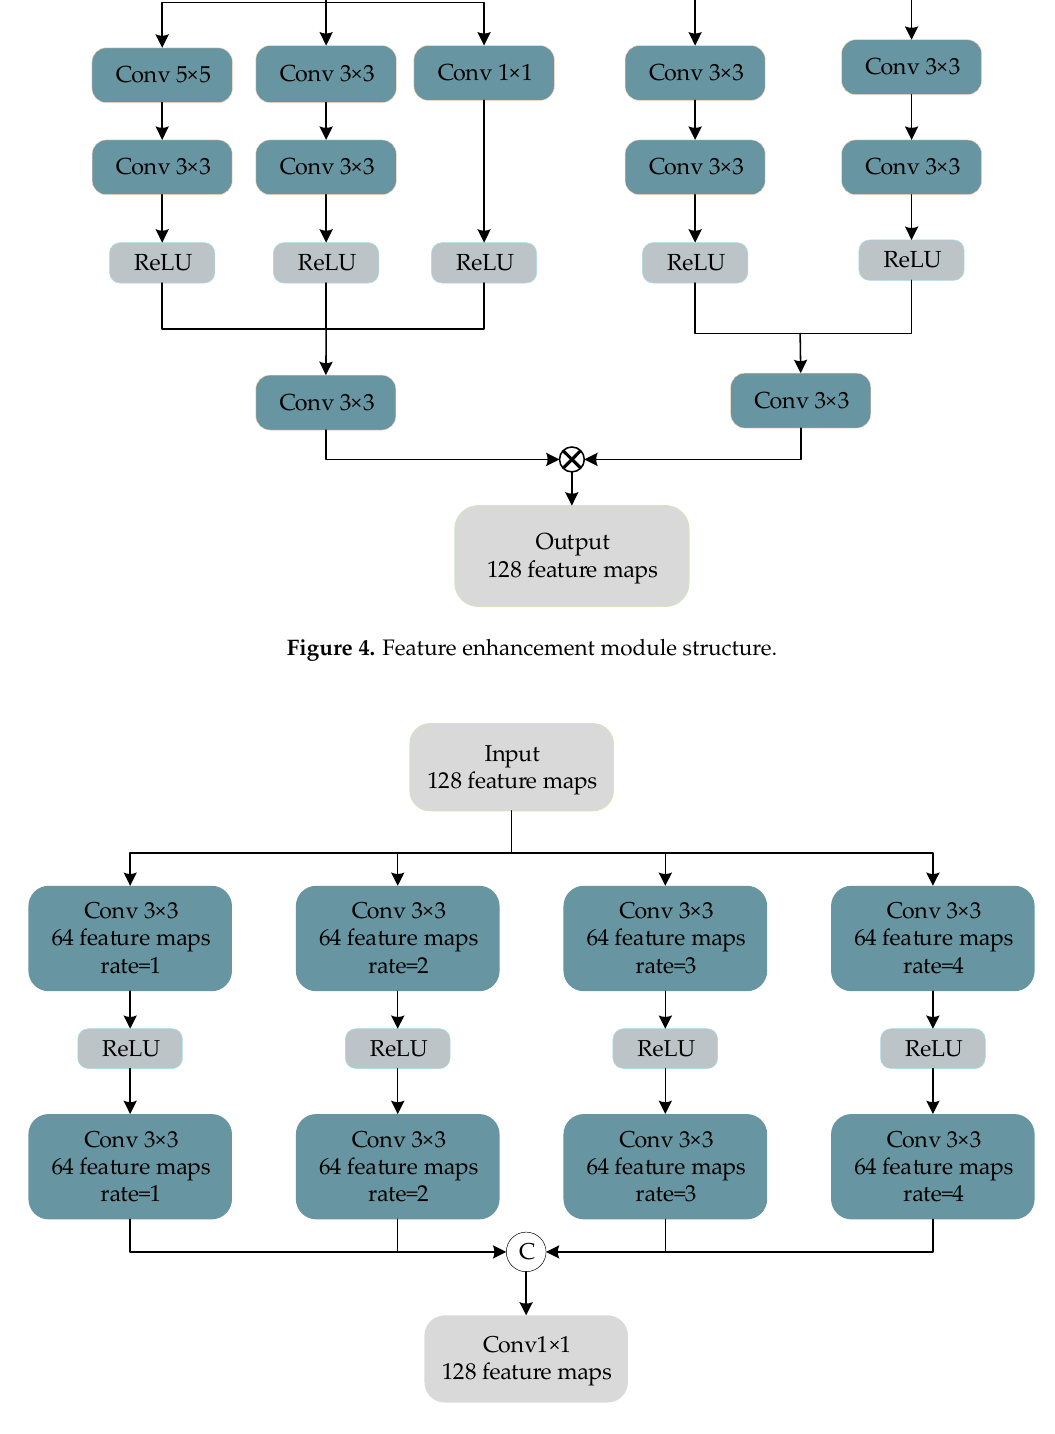
Figure 5. Hybrid dilated convolution (HDC) module.